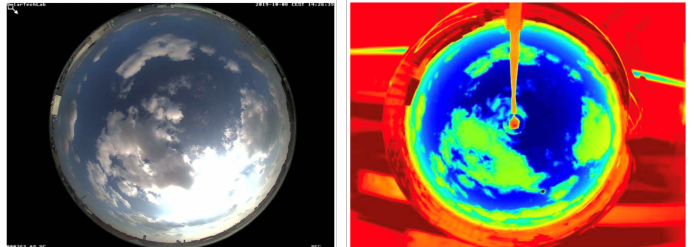
Figure 1. Same sky view acquired through different sensors in optical and infrared spectral regions.